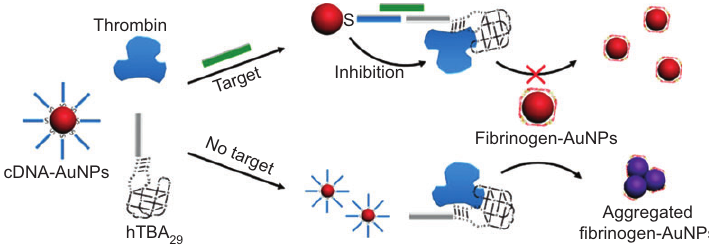
Figure 16 Schematic illustration of DNA detection based on hybridization-induced AuNP aggregation. The cross-link aggregation of ODN-functionalized AuNPs in the presence of complementary target DNA results in a change of solution color from red to blue [119]